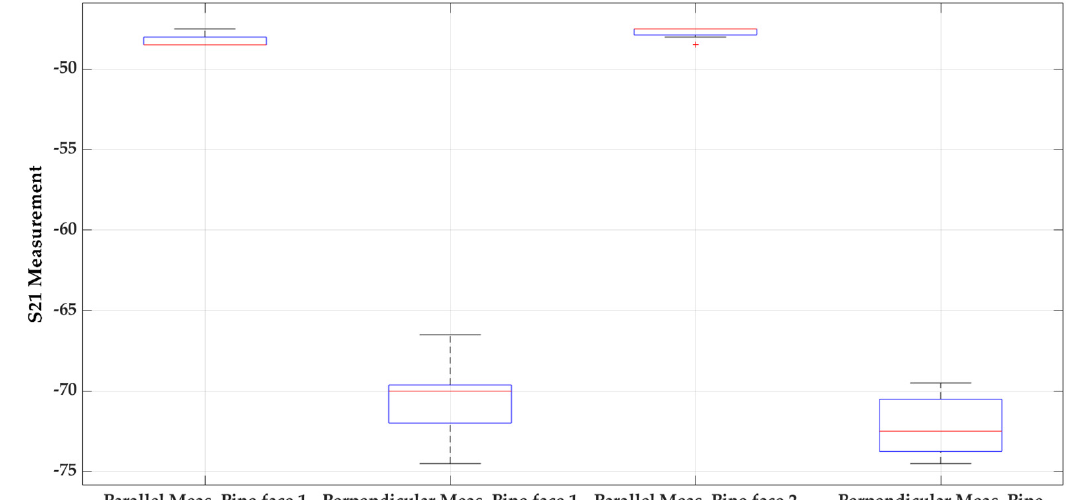
Figure 6. Box-and-whisker plot for the transmission S 21 between two faces, Face1 and Face 2, for both parallel and perpendicular polarizations. The coefficient of anisotropy for transmission at 2.4 GHz was approximately 26 dB.